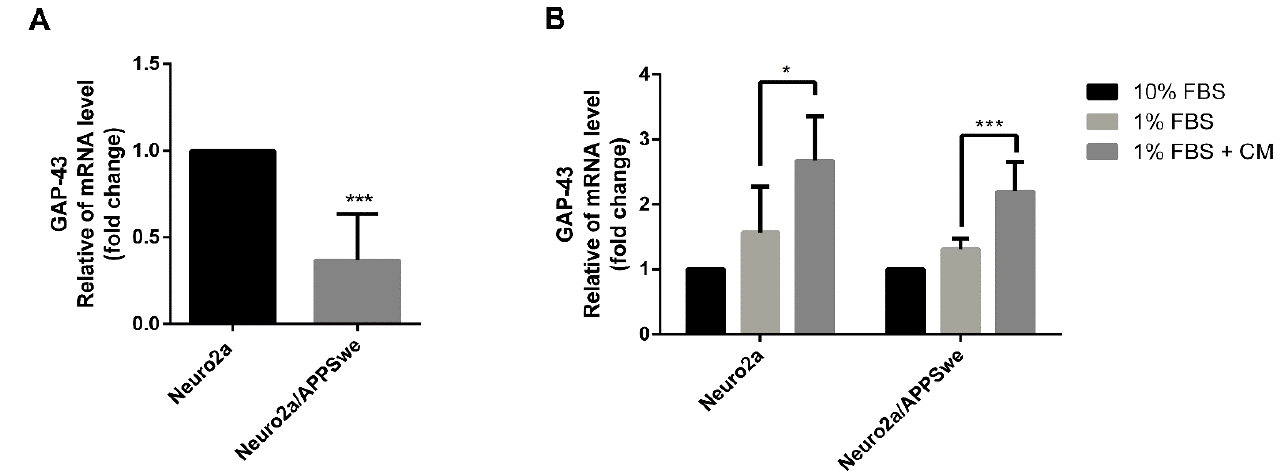
Figure 5. GAP-43 mRNA expression level. ( A ) Neuro2a/APPSwe cells showed significant lower GAP-43 gene expression than Neuro2a cells after induced differentiation by 1% FBS medium for 48 h. ( B ) The GAP-43 mRNA levels between treatment groups of Neuro2a and Neuro2a/APPSwe cells were normalized vs. 10% FBS group for each cell type. Neuro2a and Neuro2a/APPSwe cells significantly increased the expression of GAP-43 gene when treated with 10 µg/mL of CM extract for 48 h compared to 1% FBS treatment. Values are mean ± SD of at least three independent experiments. * p- value < 0.05, *** p- value < 0.001.